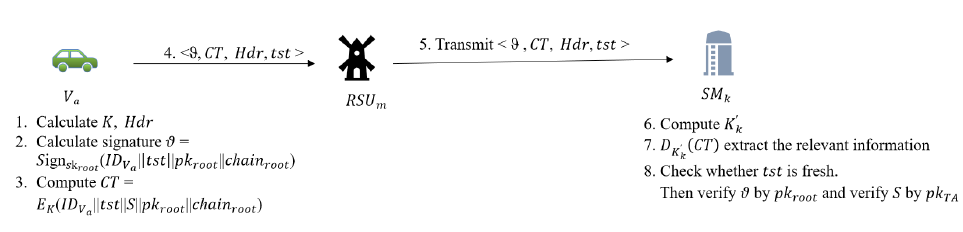
Figure 5. Identity authentication